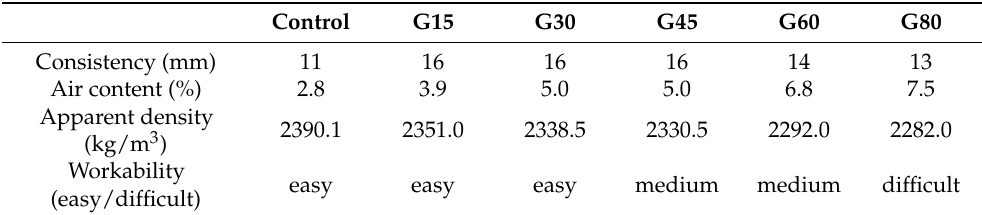
Table 3. Results obtained in the characterization of fresh concrete and concrete substituted by glass powder.